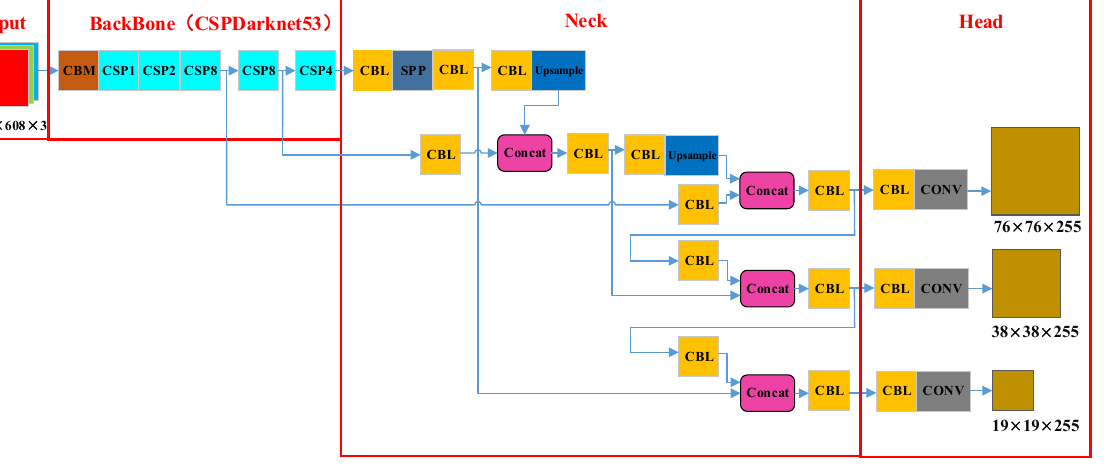
Figure 1. YOLOv4 architecture.